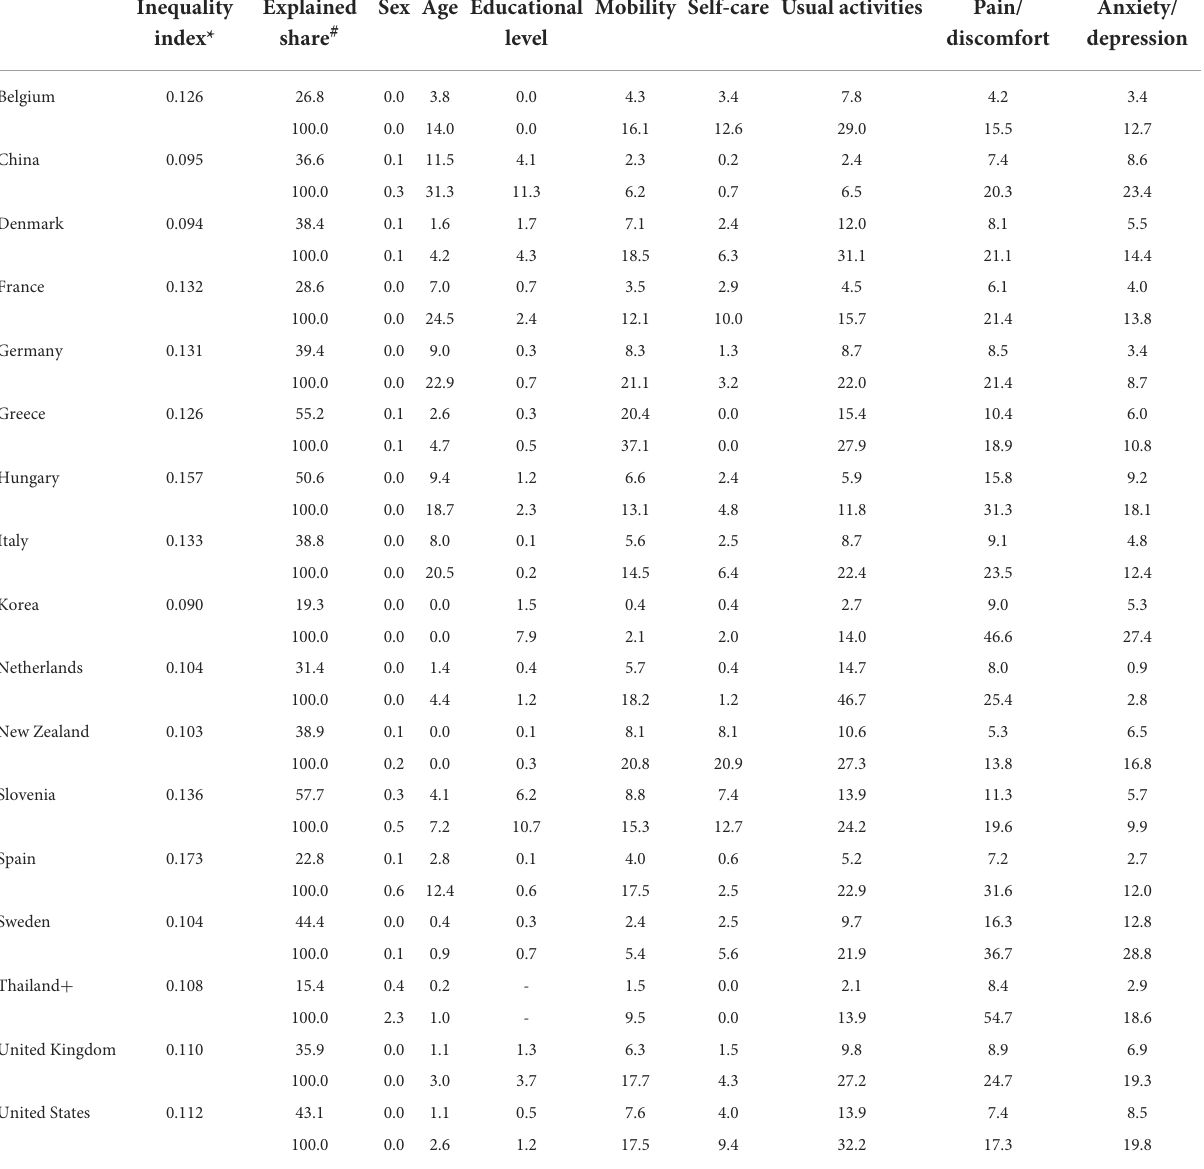
TABLE 7 Health concentration index based on overall self-assessed health measured on the EQ VAS as explained by socio-demographic indicators and the 5 dimensions of the EQ-5D-3L descriptive system. Inequality Explained Sex Age Educational Mobility Self-care Usual activities Pain/ index* share # level